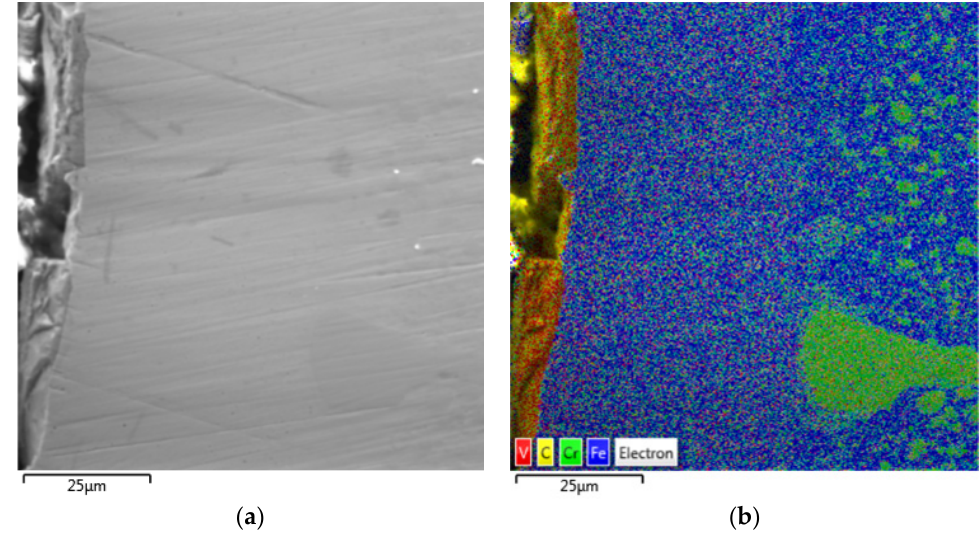
Figure 13. The Laser Cladding of VC Layers (LCVC) coating cross-section processed at 600 dpi, 100 mm/s and 1 number of heat cycles (NHC). ( a ) SEM microscope image; ( b ) Mapping.